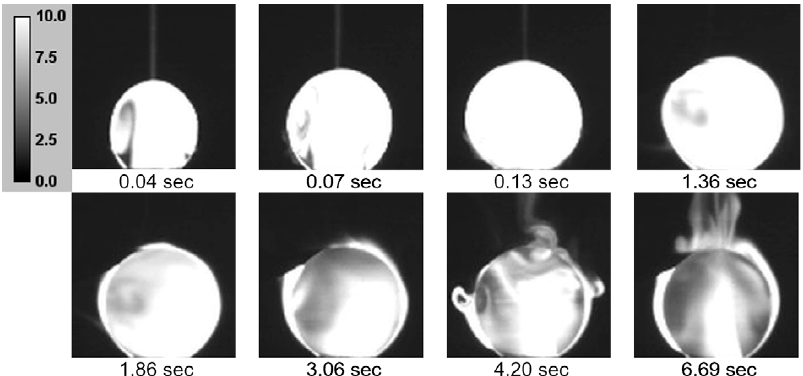
Figure 6. Visualized Marangoni effect during droplet formation. Reprinted with permission from Ref. [110]. 2019, Wiley (John Wiley and Sons). Ref. [110]. 2019, Wiley (John Wiley and